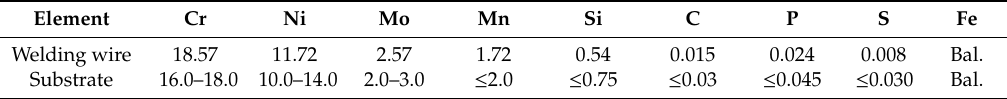
Table 1. Chemical elements of ER316L wire and substrate (mass fraction / %).